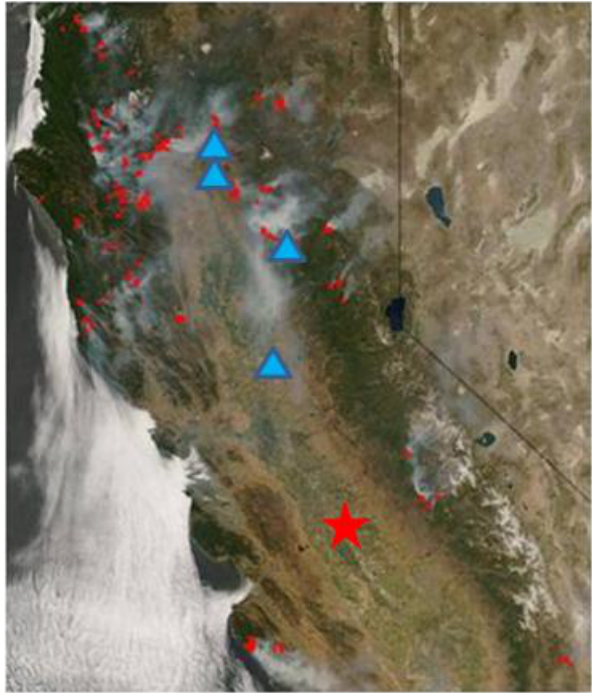
Fig. 5. Locations of the June 2008 California wildfires (captured by NASA.s Aqua Satellite, http://www.nasa.gov/topics/earth/features/ fire and smoke.html ) illustrated by the red dots. Also shown are the locations of observations sites whose data is shown in Figs. 7 and